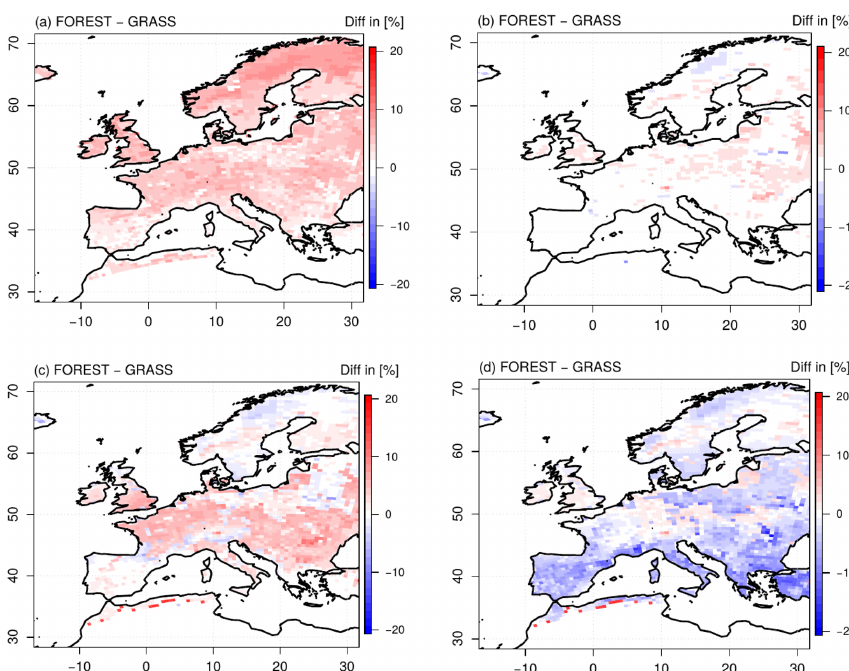
Figure 3. Differences between the FOREST and the GRASS experiments in summer for the available soil water amount for evapotranspira- tion (soil water content – residual soil water content) within the rooted soil column (a) , in the upper soil layers (until 5cm depth) (b) , at a soil depth of 15cm (c) , at a soil depth of 75cm (d) and over the simulation period 1986–2015.